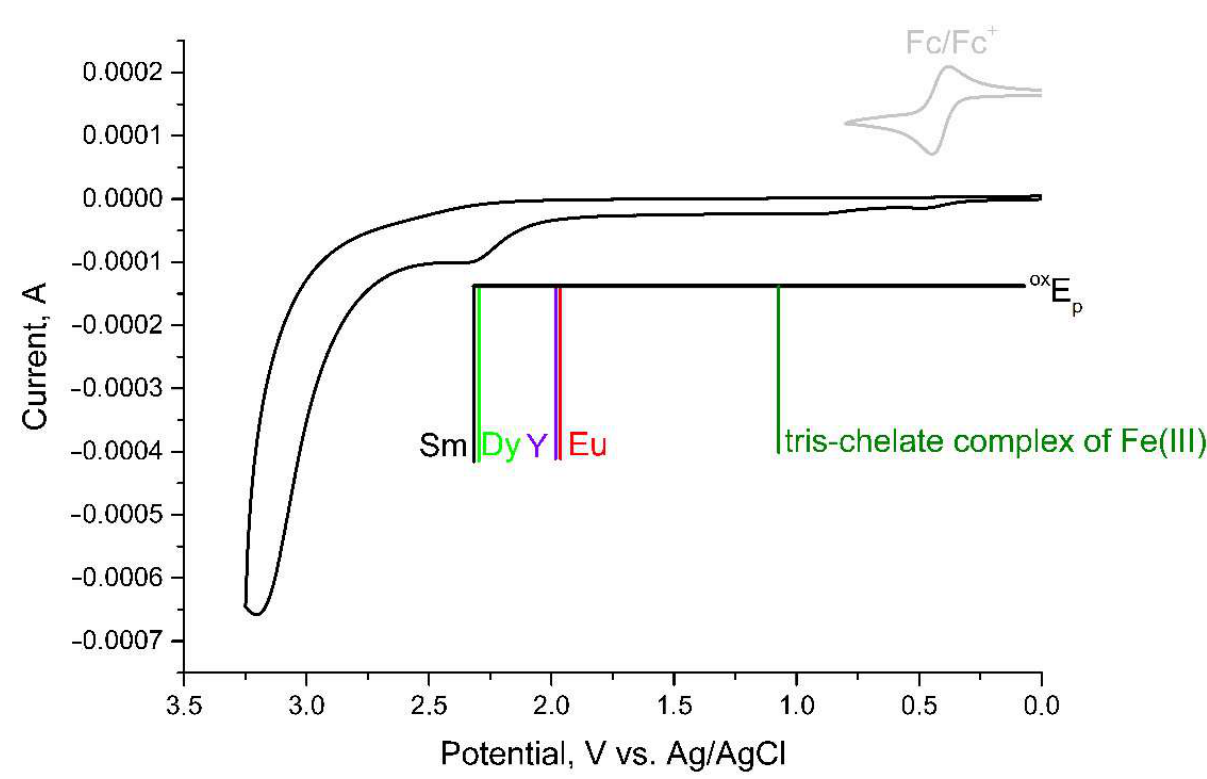
Figure 10. Cyclic voltammogram for oxidation of coordination polymer 2 . Conditions: